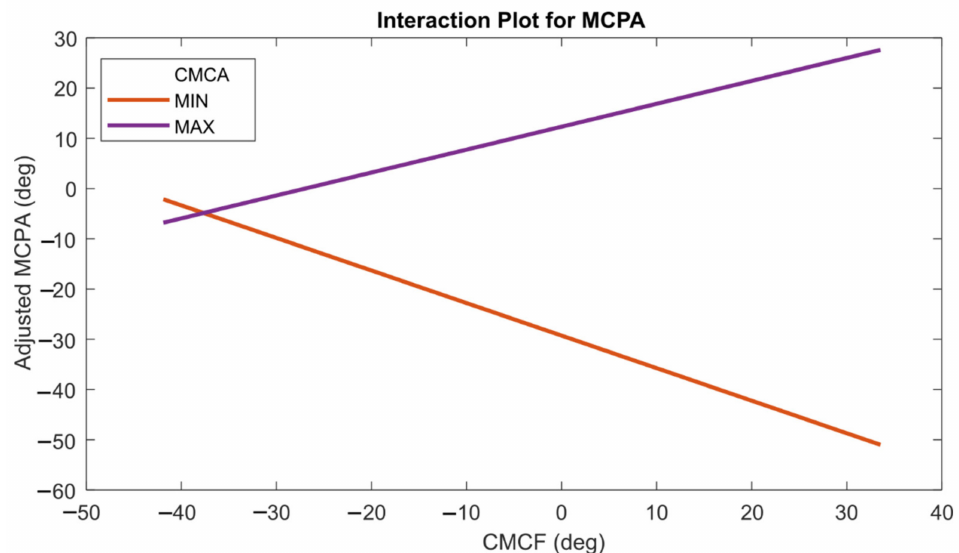
Figure 5. Interaction effect between CMC flexion/extension (CMCF) and CMC abduction/adduction (CMCA) for the estimation of MCP abduction/adduction (MCPA). The estimated effect with the other predictor fixed at extreme values (maximum (MAX; 31.55 ◦ ) and minimum (MIN; − 40.79 ◦ )).